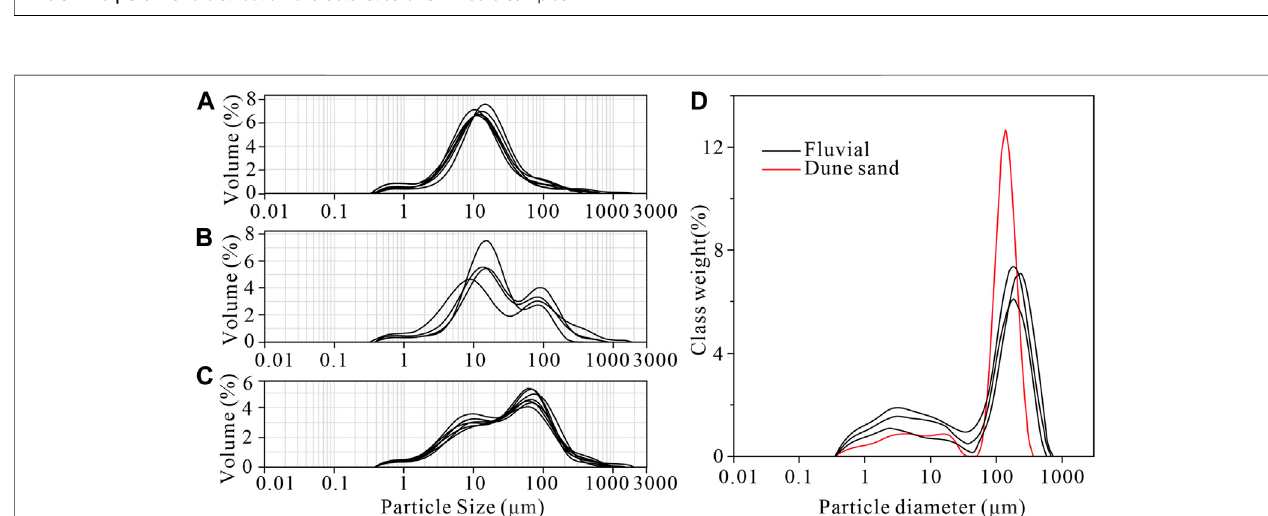
FIGURE 6 | Grain-size distribution characteristics of SL-4 core samples.